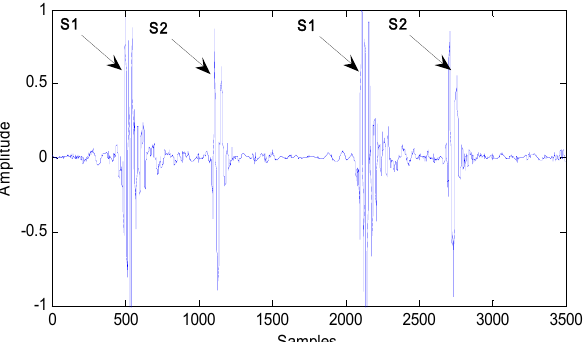
Figure 2. Typical waveform of S1 and